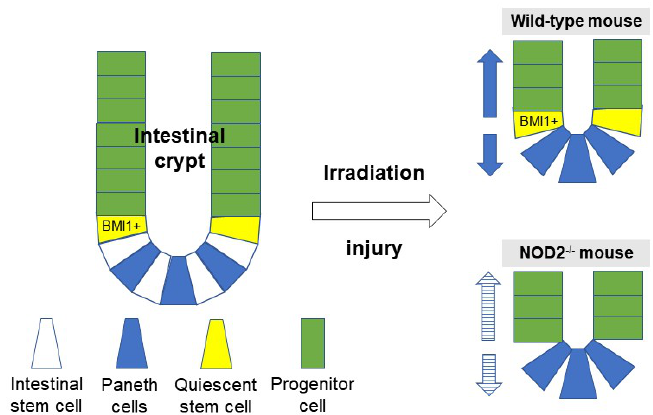
Figure 7. The proposed function of NOD2 after radiation-induced